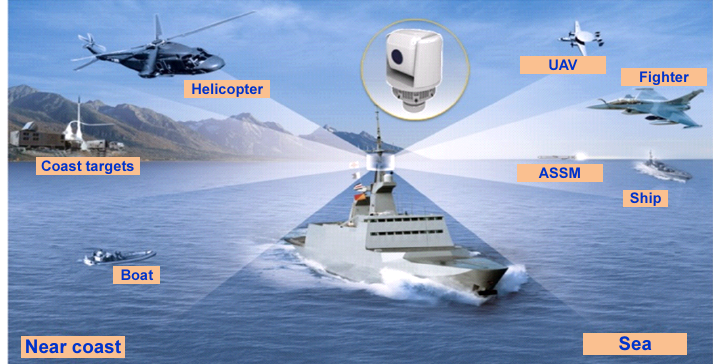
Figure 1. Operational concept of sea-based infrared search and track